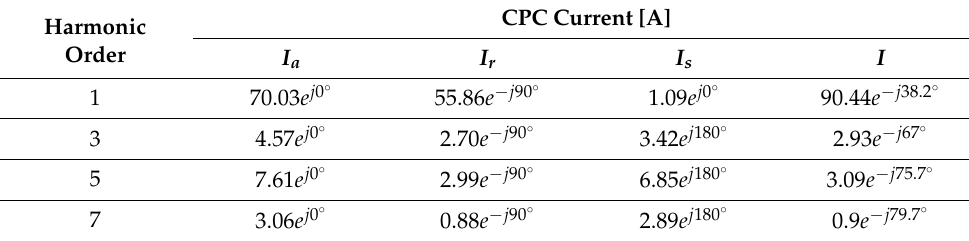
Table 6. List of complex values of currents in CPC theory.